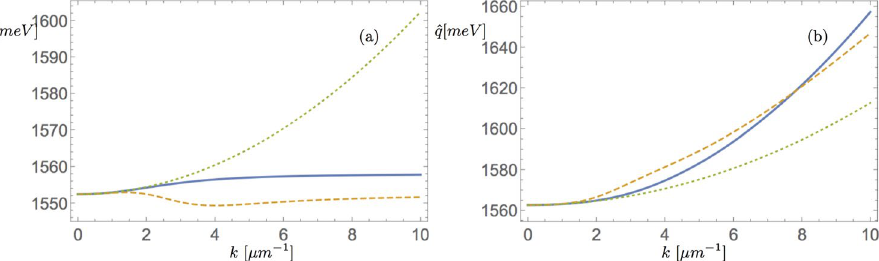
Figure 1. ( a ) Energy dispersions of the lower polariton branch: Solid line corresponds to the lower polariton dispersion, dashed line to the velocity dependent effective mass model 7 and dotted line to parabolic approximation with energy shift. ( b ) Dispersions of the upper branch: The lines are associated as